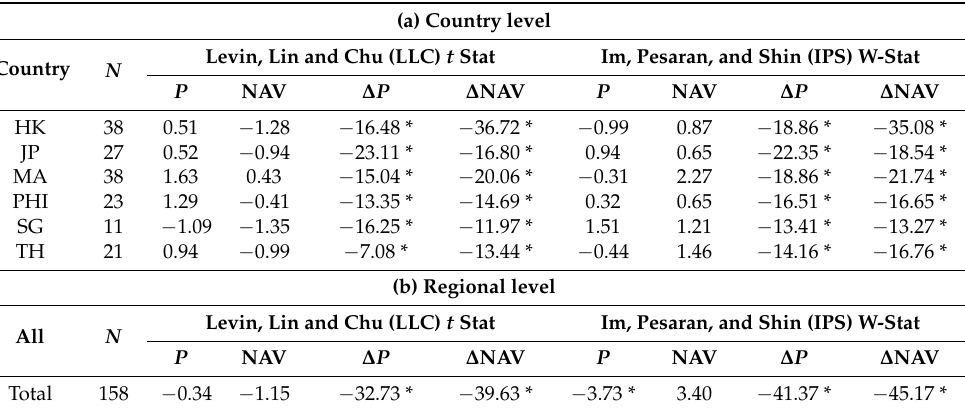
Table 2. Panel unit root test results.